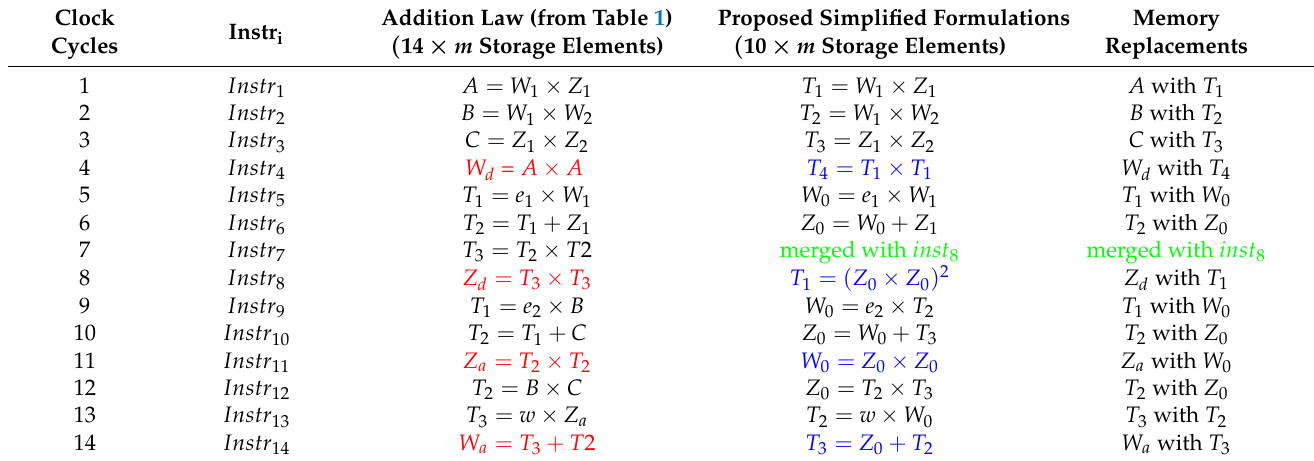
Table 2. Optimized form of complete differential addition law for